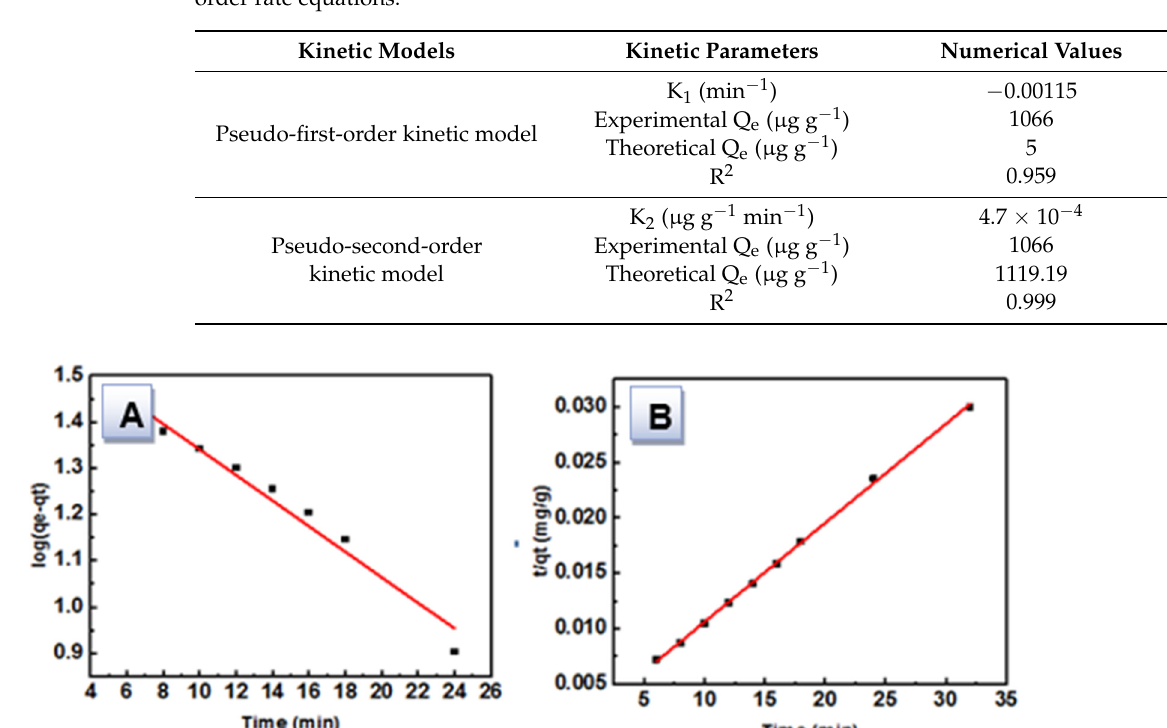
Figure 9. The plots of ( A ) pseudo-first-order kinetic plot and ( B ) pseudo-second-order kinetic plot for the percentage removal for the concentration of 0.25 g·L − 1 with the adsorbent dosage of 0.035 g·L − 1 at pH 5 of Malachite green dye. Table 2. Comparison of kinetic parameters associated with pseudo-first order and pseudo-second- order rate